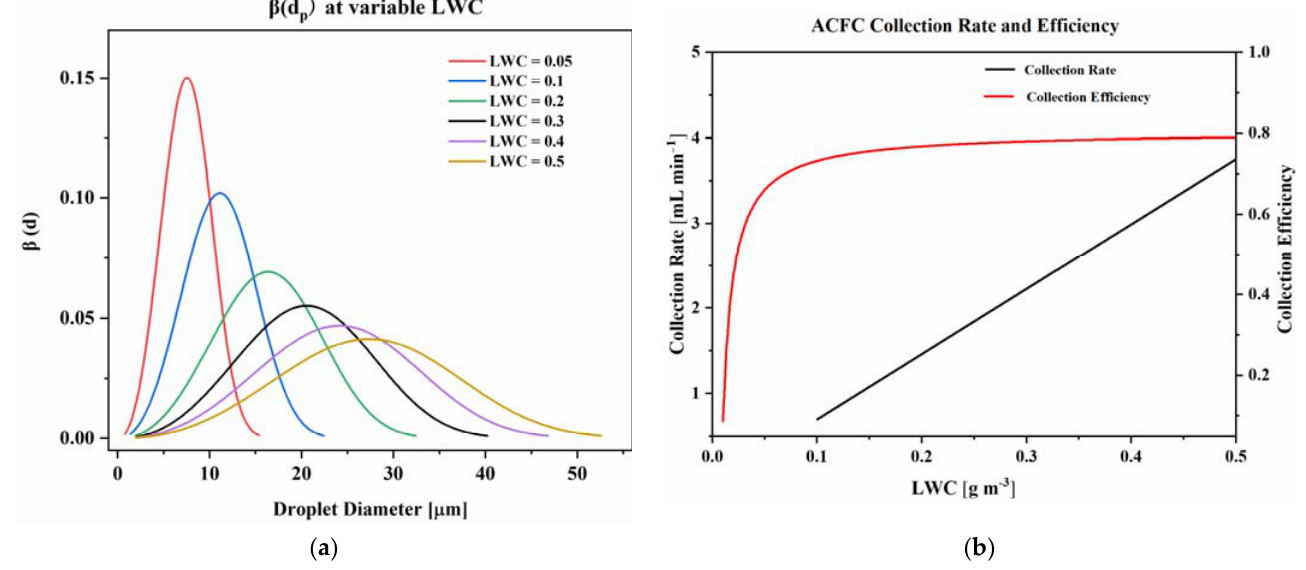
Figure 5. ( a ) β (d p ) as a function of some given LWC values. ( b ) ACFC collection rate and collection efficiency as a function of liquid water content (LWC). Droplet spectra were calculated with the same approach as in Demoz et al. (1996) using the theoretical droplet size spectra according to Best